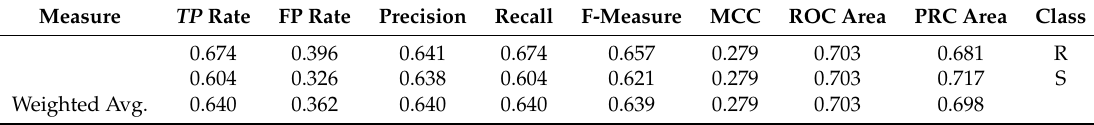
Table 8. Detailed accuracy by class of random forest (10-fold